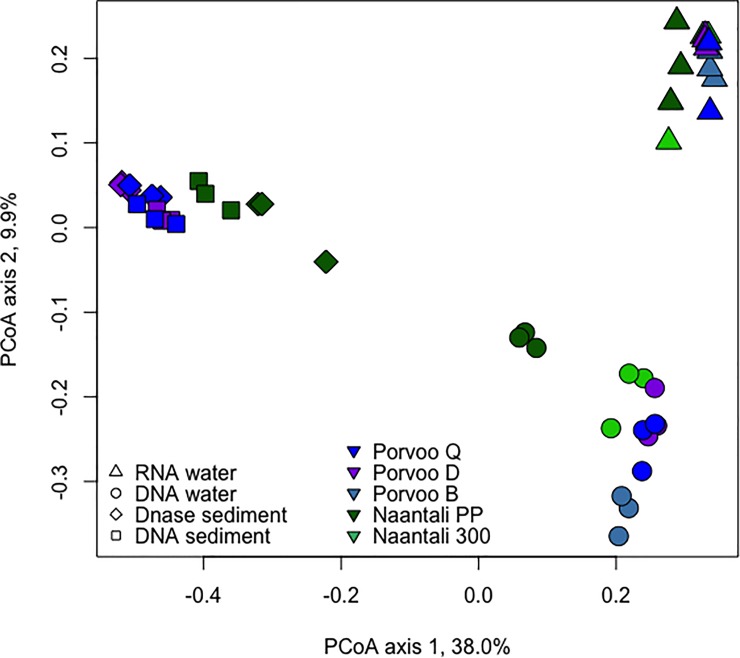
Principal coordinates analysis of combined bacterial, archaeal and fungal community compositions.PCoA from water and sediment samples. No archaeal sequence data was obtained from Naantali 300 and Porvoo B sediment samples, and these samples are removed from the analysis.